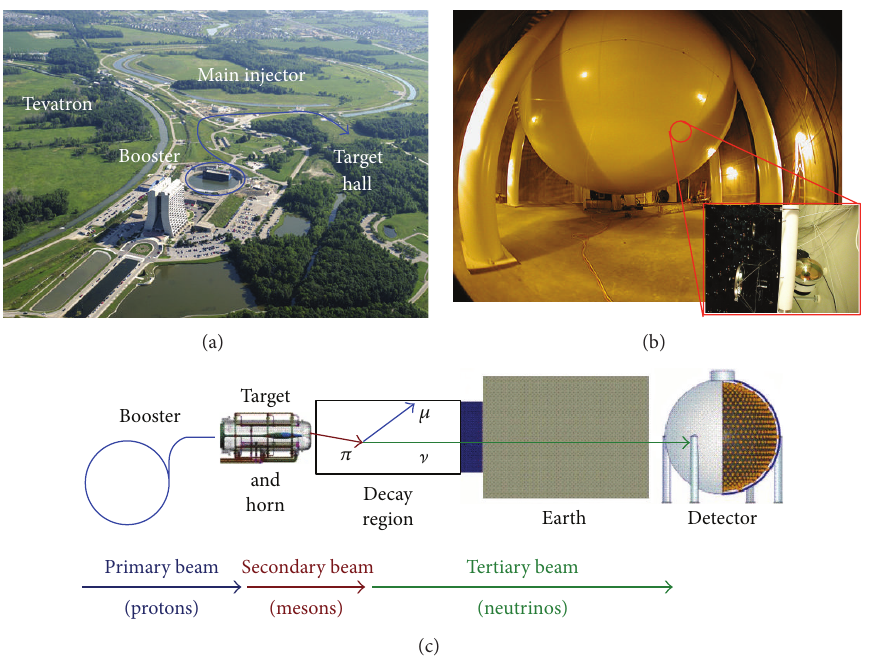
Figure 1: The MiniBooNE experiment layout [4]. (a) The Fermilab accelerator complex. (b) The MiniBooNE detector, with inset showing the black inner volume and the white outer volume. (c) Schematic layout of the beam and detector